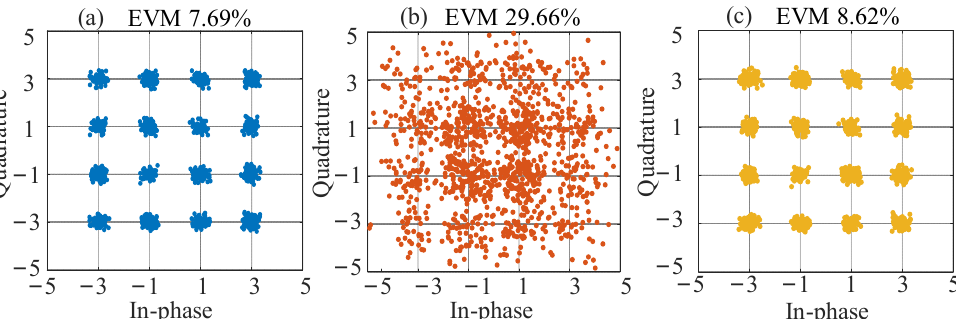
Figure 8. Demodulated constellation diagrams of IF signal when the SOI signal was centered at 31.1 GHz ( a ) without transmission over fiber ( b ), without DIPF compensation, and ( c ) with DIPF compensation over 25 km fiber transmission with SIC enabled.